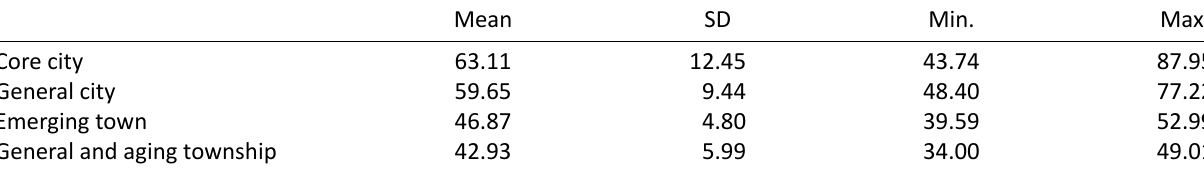
Table 3. Descriptive statistics of average school income by level of urbanisation.